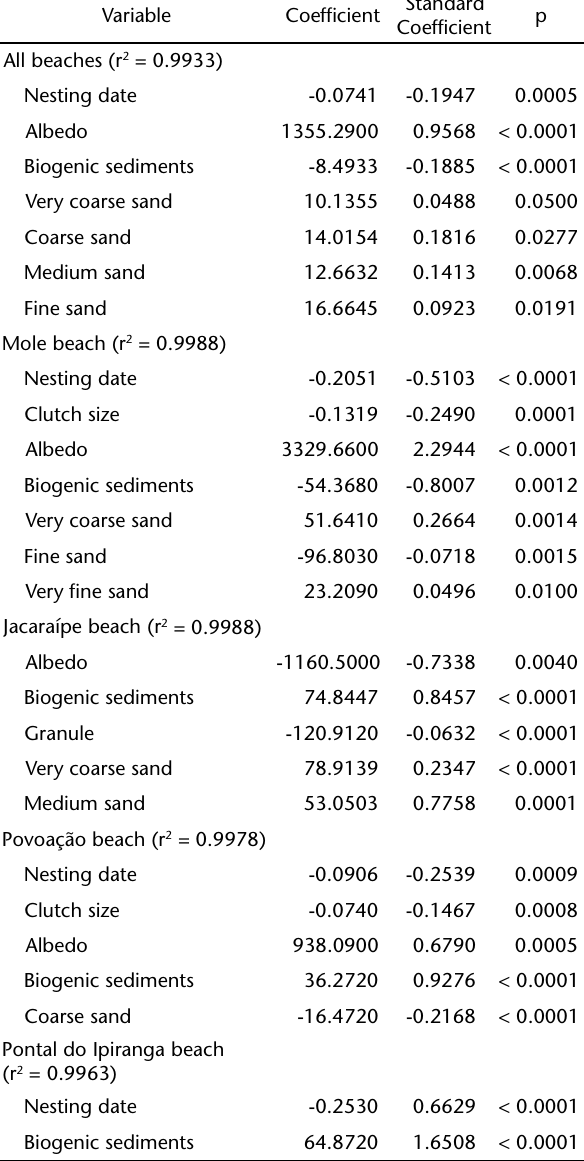
Table III. Stepwise backwards multiple linear regression for incubation duration of C. caretta in all beaches and in each beach